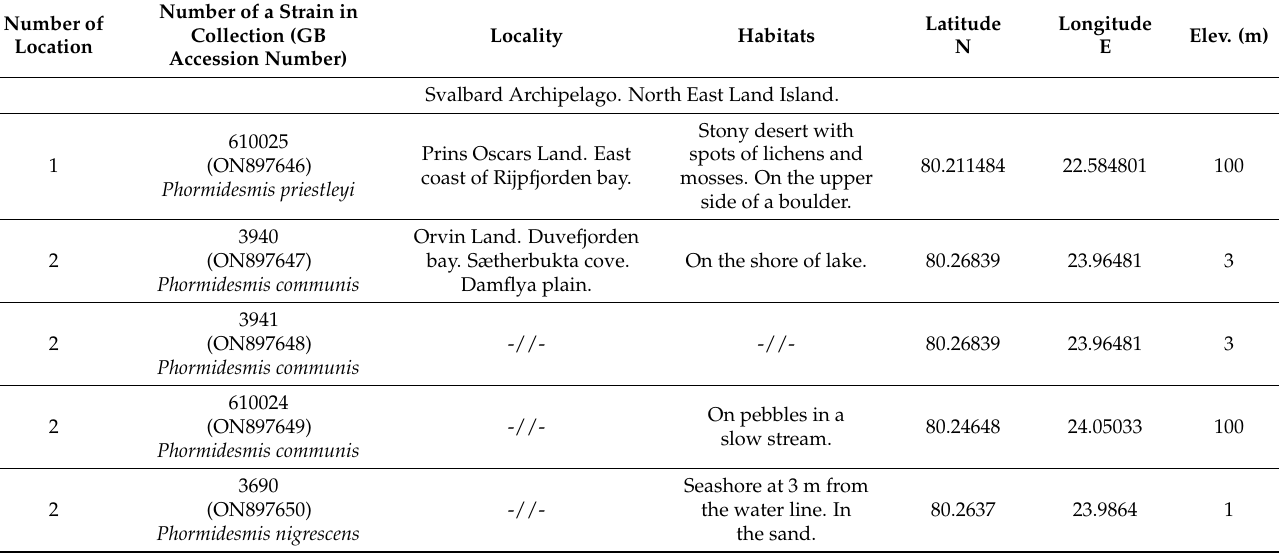
Table 1. Description of sampling